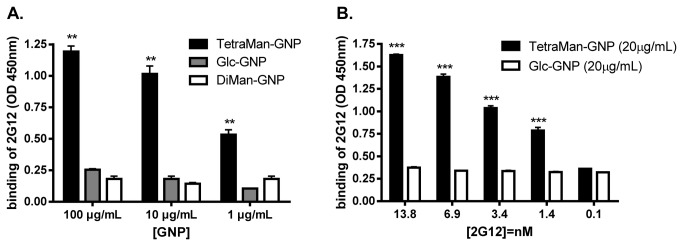
Detection of anti-HIV monoclonal antibody 2G12 by GNP-ELISA.(A) TetraMan, DiMan and Glc-GNP at different concentrations (100, 10, and 1 µg/mL) were used for ELISA plates coating. Antibody 2G12 (2.4 µg/mL, 16 nM) recognizes TetraMan-GNP in a coating-concentration dependent manner, while DiMan-GNP and Glc-GNP are not recognized. Differences between TetraMan-GNP and both control GNPs are significant, as indicated with two asterisks (p<0.01). (B) Limit of 2G12 detection with TetraMan-GNP: 20 µg/mL of GNPs were used to coat the plate and subsequently incubated with different concentrations of 2G12 (13.8 to 0.1 nM). Error bars represent the standard deviation of three different experiments. Differences between TetraMan-GNP and both control GNPs are significant, as indicated with three asterisks (p<0.001). Background signal due to non-specific interactions was around OD 0.25.